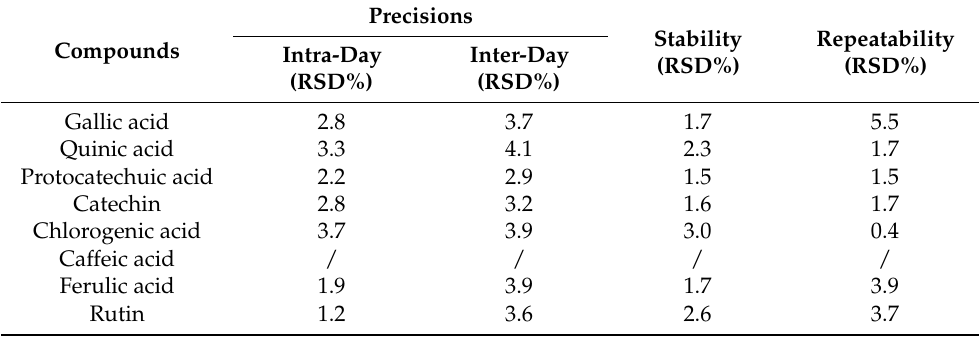
Table 5. Precision, stability, and repeatability of phenolic compounds in 10 banana cultivars ( n =